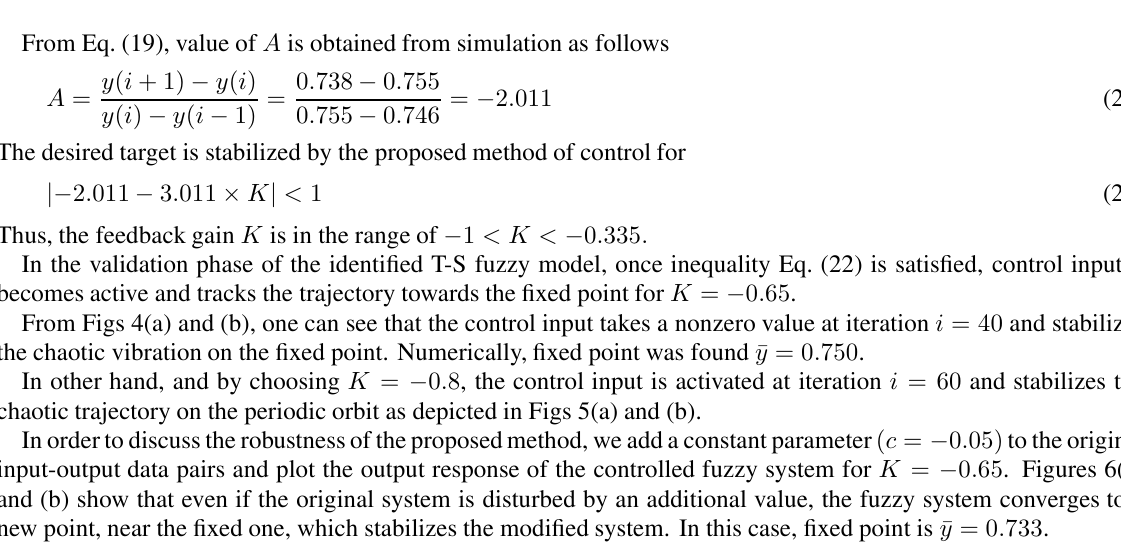
Fig. 5. T-S Fuzzy system stabilized on periodic orbit. (a) Behavior of y ( i ) . (b) Control input u ( i )